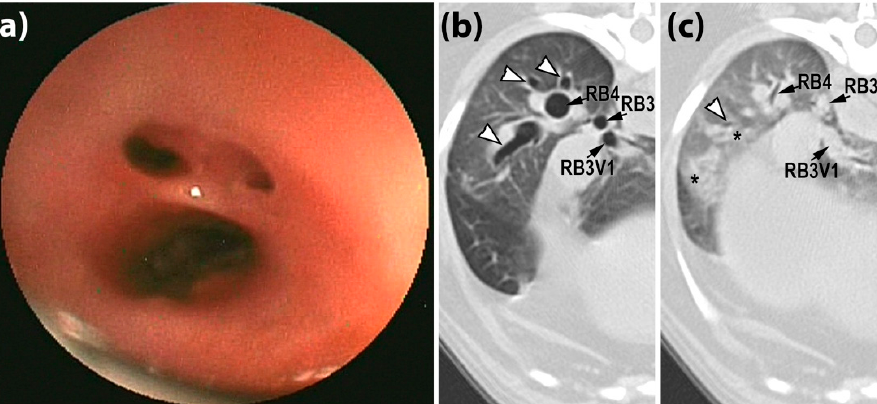
Figure 2. Tracheobronchoscopic and paired inspiratory/expiratory breath-hold CT images from an 8-year-old female spayed Pug in the airway collapse (AC) group. ( a ) The endoscopic image of subsegmental bronchi in the right caudal lung lobe was given a score of 2, reflecting 51–75% luminal diameter narrowing. The paired inspiratory ( b ) and expiratory ( c ) CT images were given a score of 3 as there was near complete disappearance of the lumen of lobar (RB3, RB4), and segmental (RB3V1) and subsegmental (white arrowheads) airways with a marked increase in peribronchovascular opacification on the expiratory series (*). RB3, right accessory lobar bronchus; RB4, right caudal lobar bronchus; RB3V1, first ventral branch of right accessory lobar